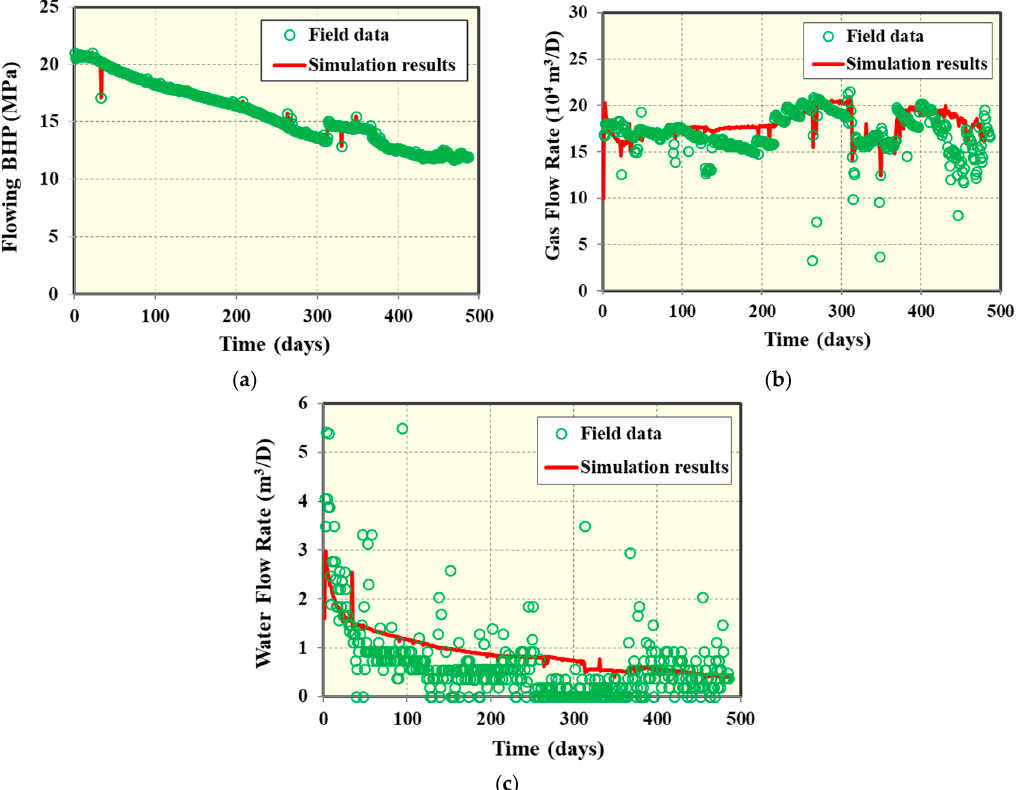
Figure 3. Comparison of flowing BHP and gas and water flow rates between filed data and simulation results: ( a ) Flowing BHP; ( b ) Gas flow rate; ( c ) Water flow rate.